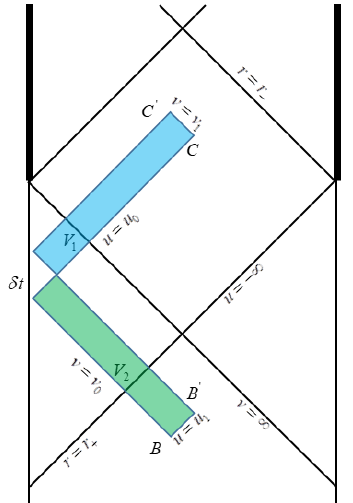
Figure 2 . The action growth of the WDW patch of an uncharged black hole. In the time process t L ! t L + (cid:14)t , the patch loses a sliver V 2 (Blue) and gains another one V 1